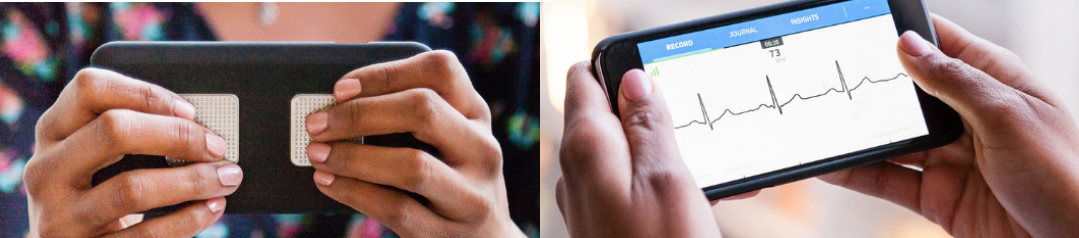
Figure 1. Example of the commercial off-the person mobile equipment used to capture the ECG signal. Source: https://www.alivecor.com/en/.